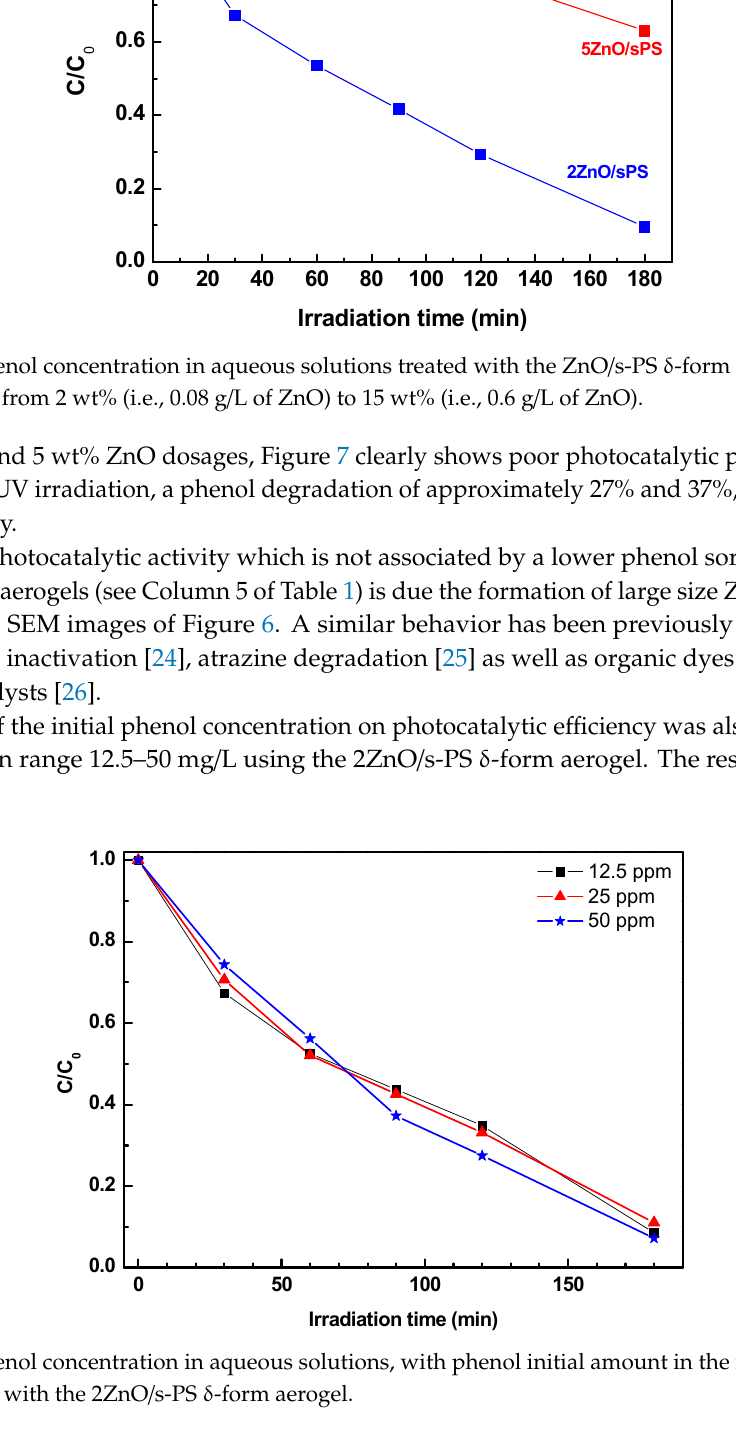
Figure 6. SEM images of the ZnO/s-PS δ -form aerogels with 15 wt% ( a ) and 5 wt% ( b ) of ZnO. Some ZnO aggregates are indicated by yellow circles (scale bar: 50 µm).